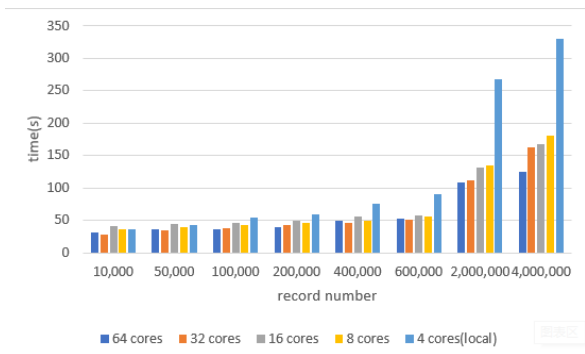
Figure 10. Computing time on different data size when using different number of CPU cores